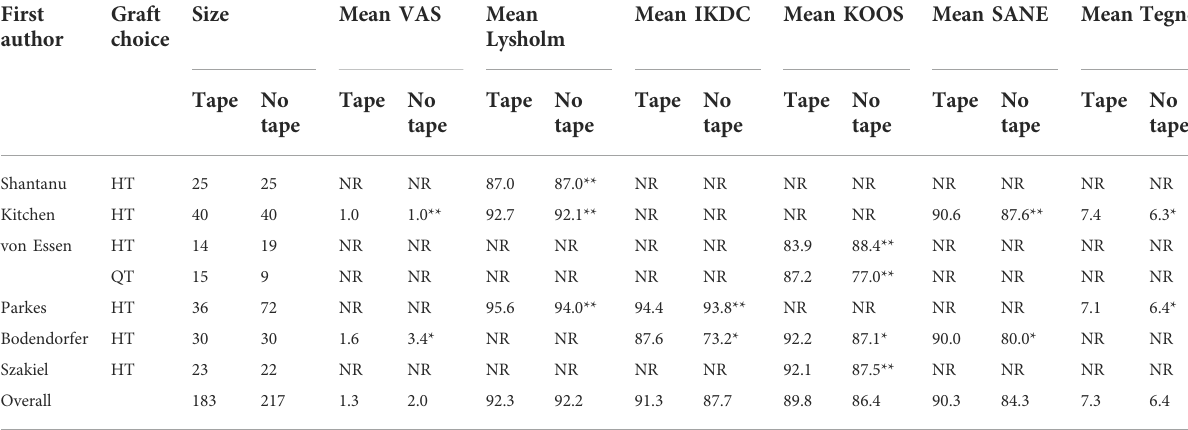
TABLE 5 Postoperative subjective scores between anterior cruciate ligament reconstruction with or without suture tape augmentation.